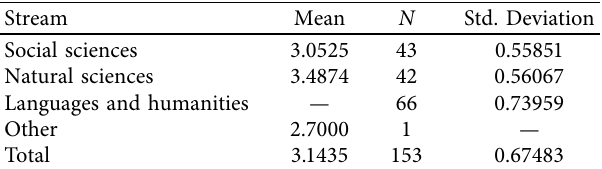
Table 8: Global reputation means by stream.